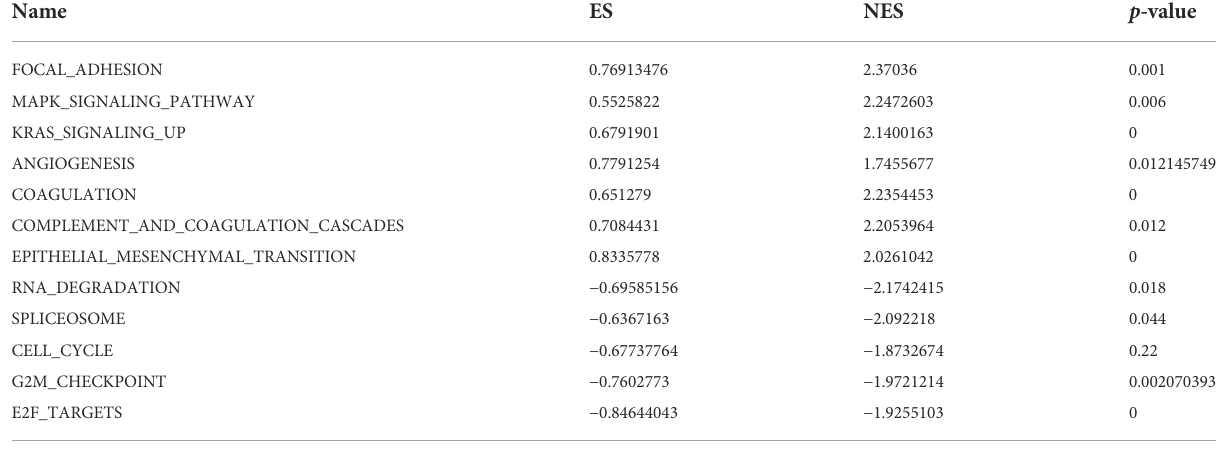
TABLE 1 Result of Gene Set Enrichment Analysis (GSEA) between high-risk and low-risk groups.